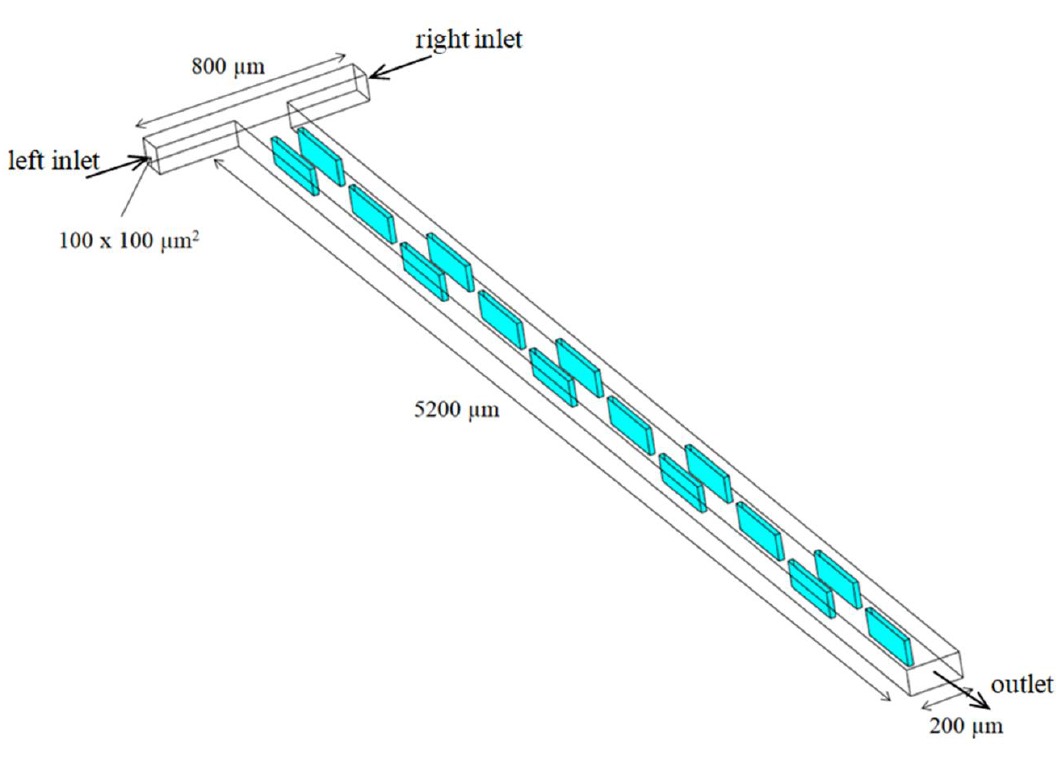
Figure 1. 3-D schematic of T-mixer with TDOs